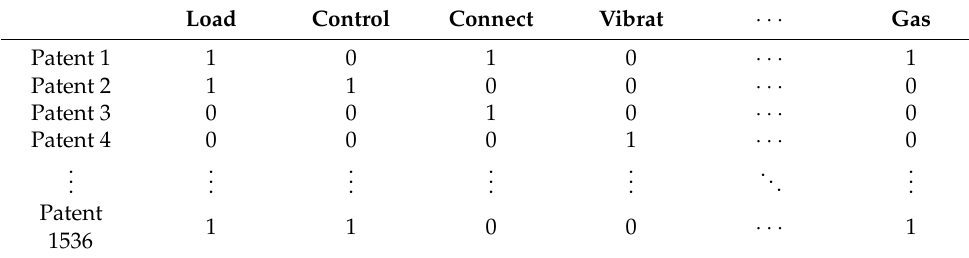
Table 2. The format of the significant keywords’